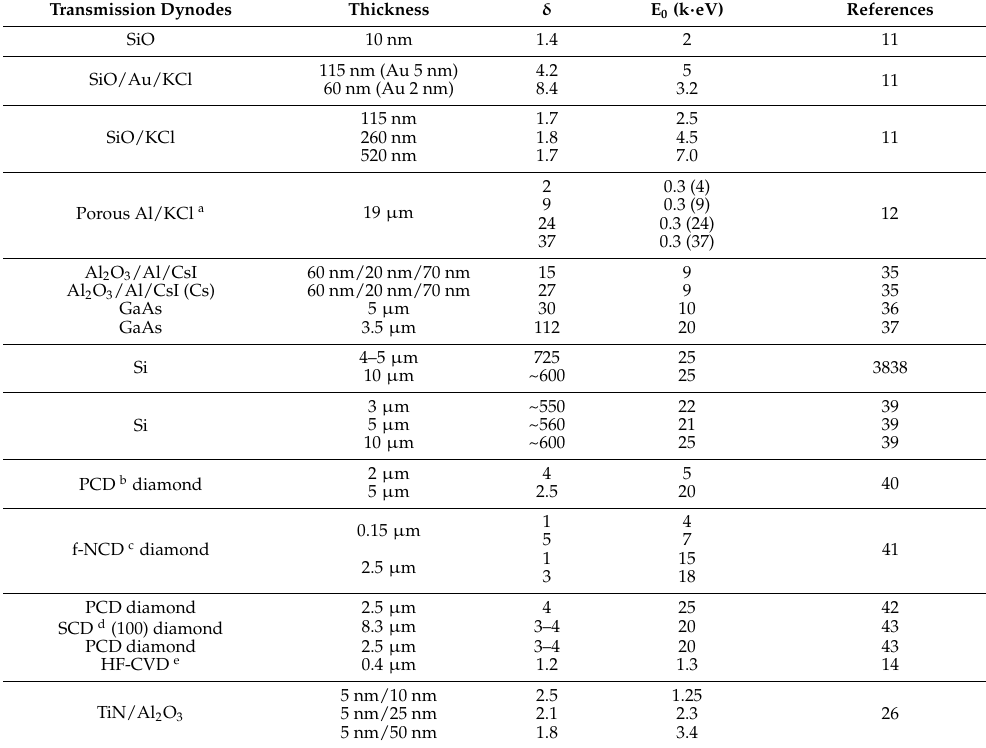
Table 2. Transmission dynodes or materials with TSEY ( δ ) higher than 1 (see Figure 2 and Section 3 for illustration and definition of TSEY, respectively.) and E 0 is the energy of the primary